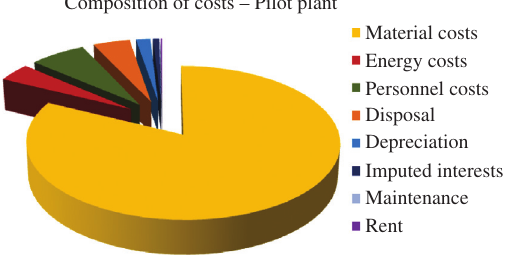
Figure 9 Composition of future production costs for the epoxidized soybean oil (ESBO) pilot plant, best case